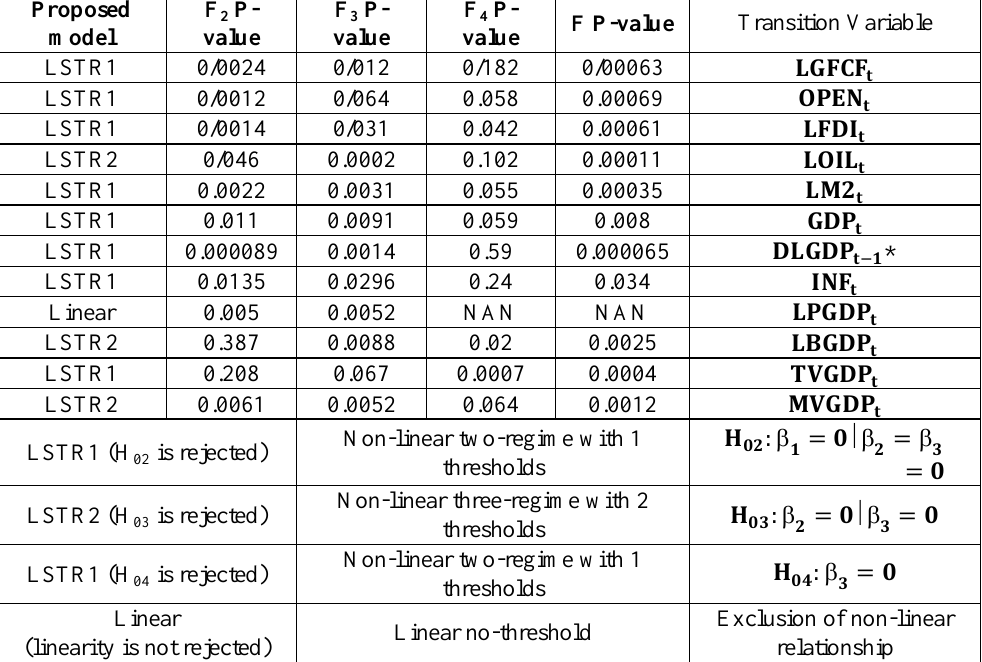
Table 7. Model type and transition